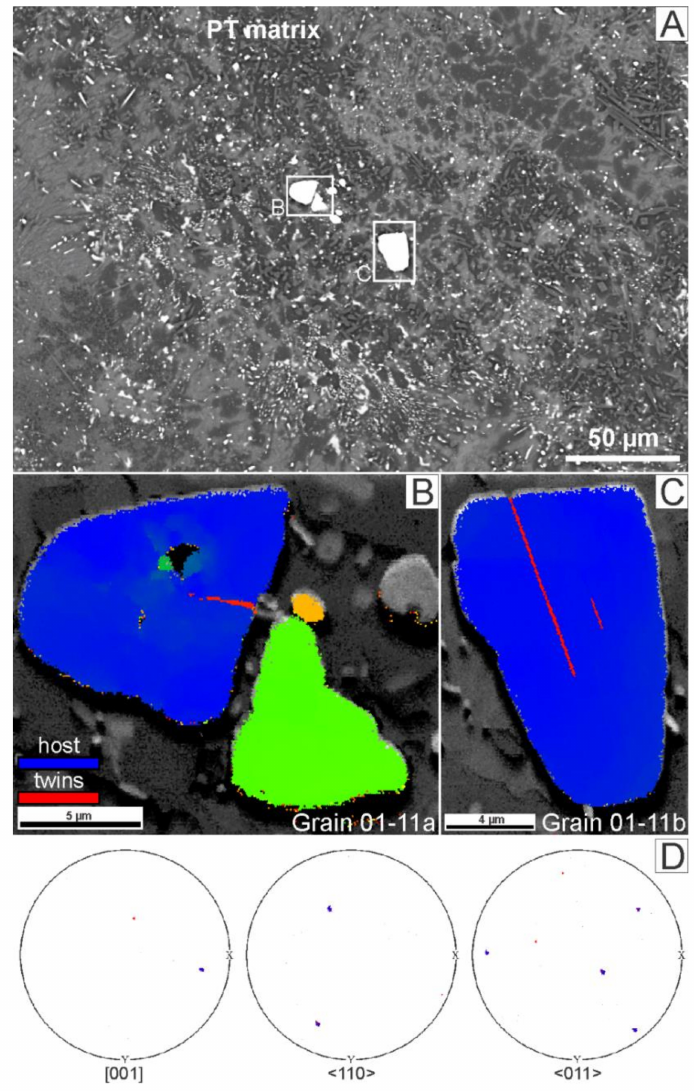
Figure 9. Fragmented zircon grain 01-11 in the PT matrix. ( A ) BSE image, showing the fragmented grain at ( B , C ). ( B ) EBSD map of the upper left fragment (01-11a), color-coded according to the orientation: the host grain is colored blue, and the microtwin lamella, rotated at 65 ◦ to the host lattice about < 110 > , is colored red. ( C ) EBSD map of the lower right fragment (01-11b), color-coded according to the orientation: host grain is colored blue and microtwin lamellae, rotated at 65 ◦ to the host lattice about < 110 > , are colored red. The step size for both maps is 80 nm, plotted with the EDAX OIM v7.3 Analysis software. ( D ) Pole figures for grain 01-11b for [001], < 110 > and < 011 > , color-coded as in ( C ). Plotted with the MATLAB MTEX